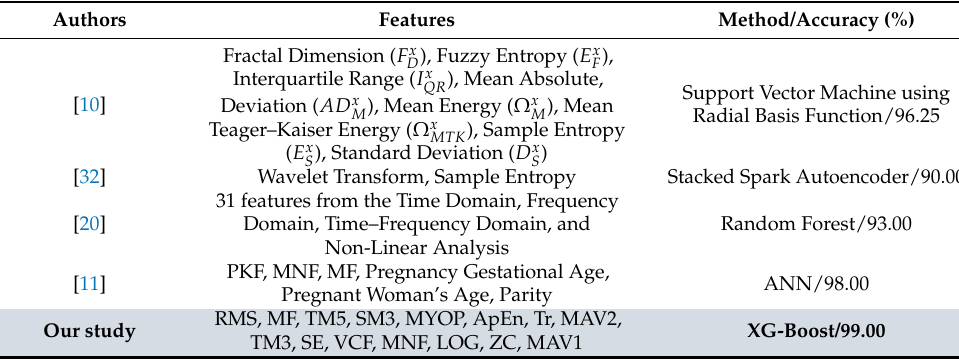
Table 3. EHG signal classification methods with features in two or more